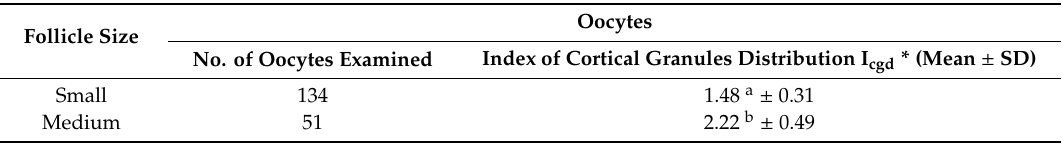
Table 1. Cortical granule distribution in porcine germinal vesicle stage (GV) oocytes collected from different-sized follicles.